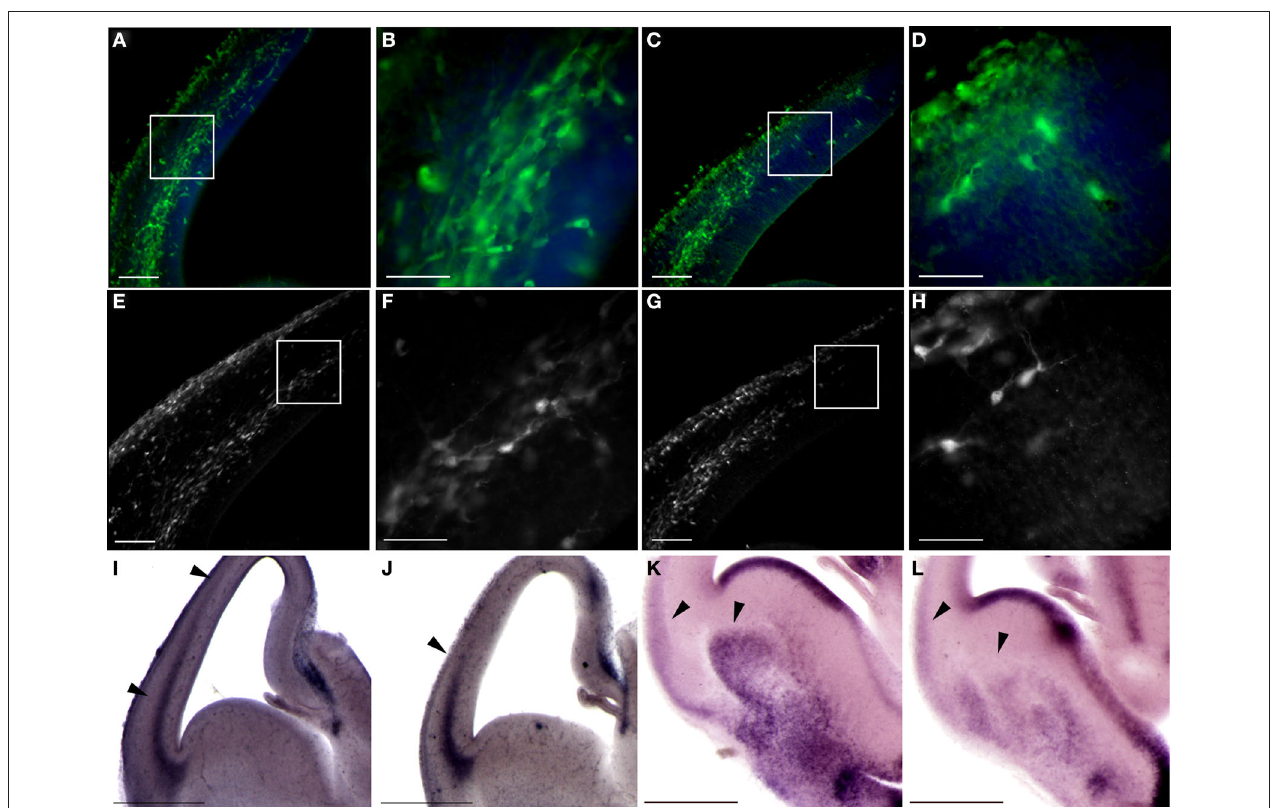
FIgure 8 | Double KO mice exhibit advanced tangential migration. (A–D) GAD67-GFP-labeled interneurons are found in more advanced positions in double KO brain sections (A,B) in comparison with control sections (C,D) . Scale bars in (A) and (C) is 100 μm, and in (B) and (D) is 40 μm. (e,F) Calbindin immunostaining, which identifies a subgroup of interneurons, demonstrates advanced positioning of these interneurons in